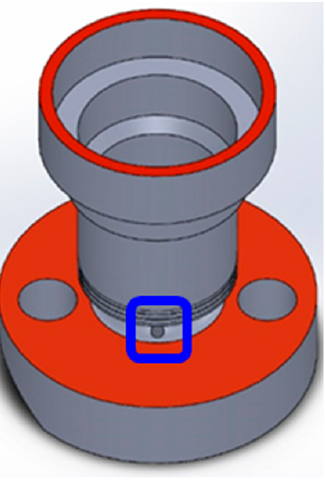
Figure 8. Workpiece and detection target (circular hole) indicated by the blue square.